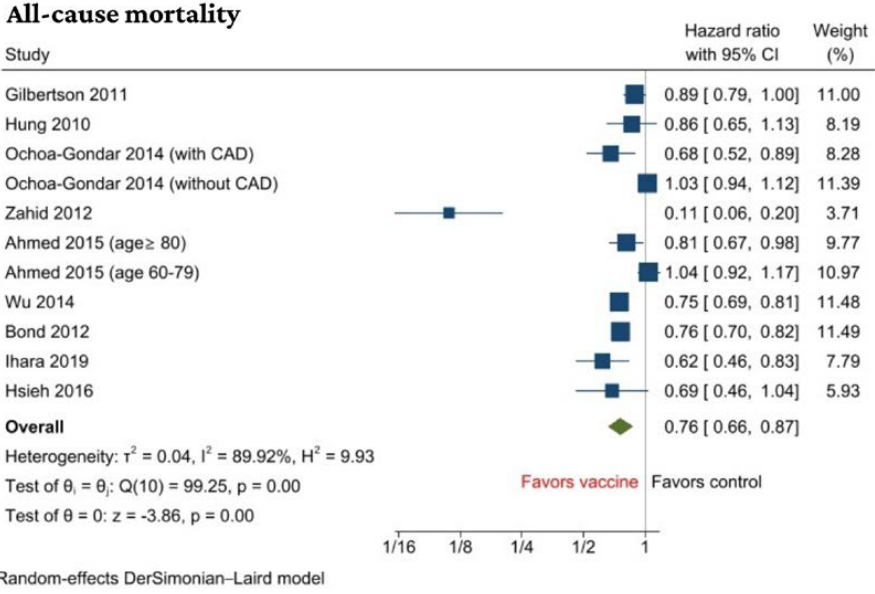
Figure 2. Forest plot of primary outcome: all-cause mortality [31,32,34,35,37,38,41–43].